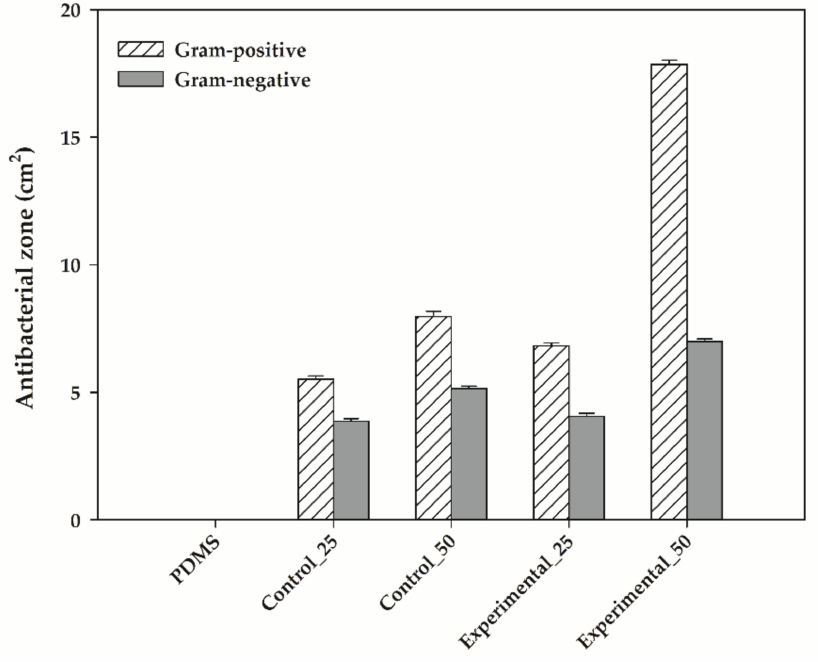
Figure 5. Antibacterial activities of the bioelastomers against Gram-positive ( S. aureus ) and Gram-negative ( E. coli